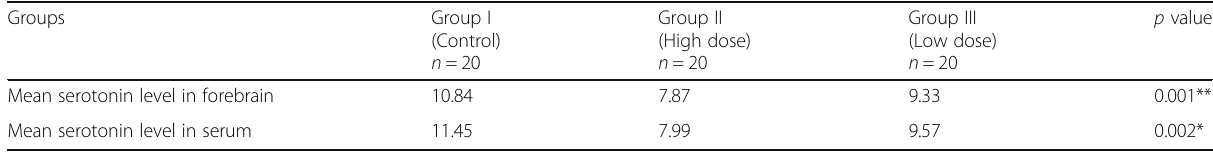
Table 3 The level of serotonin (mean) in the forebrain and serum in the three groups after treatment using one way ANOVA Groups